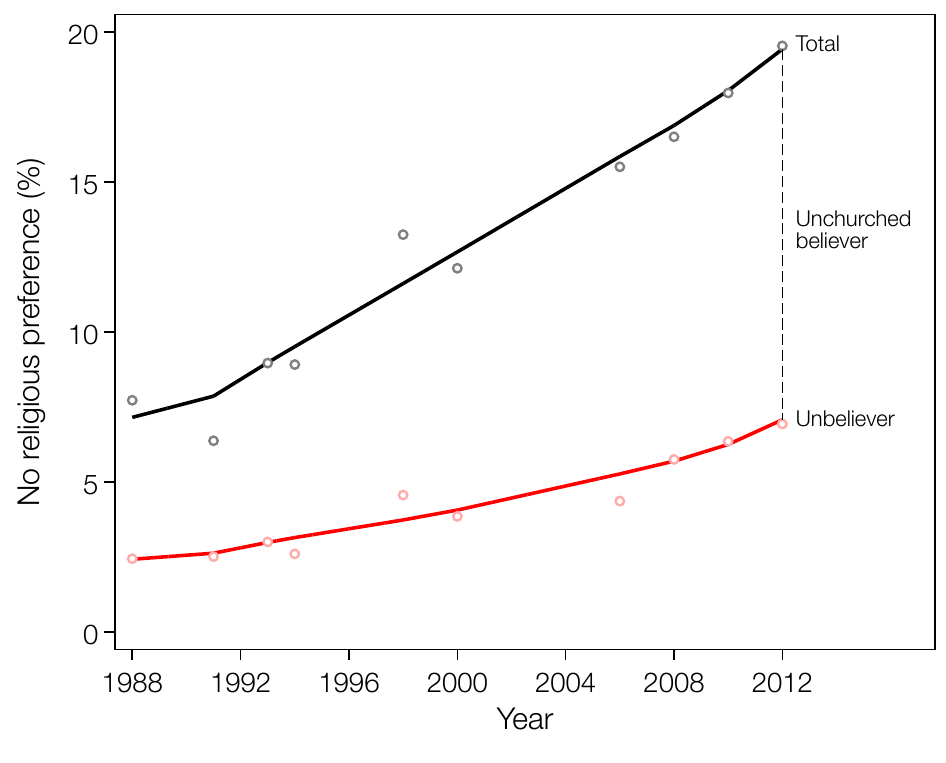
Figure 5: Decomposition of Percentage Stating No Religious Preference into Unchurched Unbelievers and Unchurched Believers: Adults, United States,